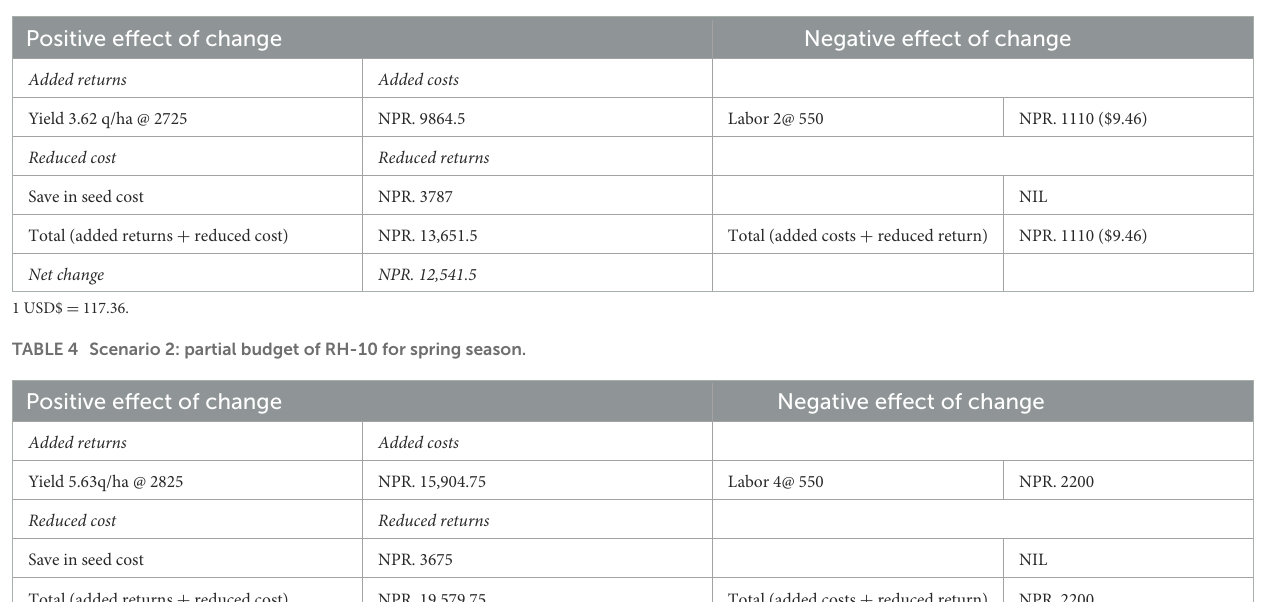
TABLE 3 Scenario 1: partial budget of RH-10 for full sample size (regardless of location and season).